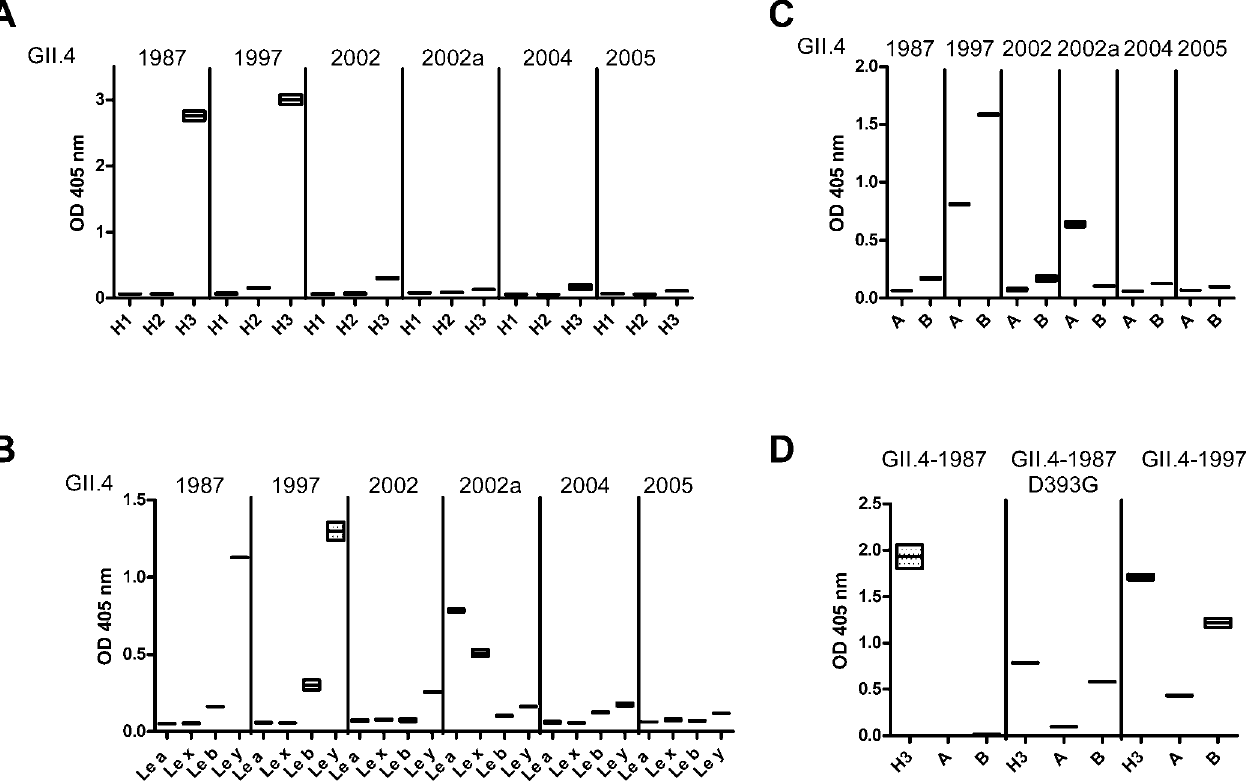
Figure 7. GII.4 VLP–Carbohydrate Binding Patterns at Room Temperature VLPs were assayed for ability to bind to synthetic biotinylated HBGA bound to avidin-coated plates. The mean optical density is indicated by the line in the box. The upper and lower boundaries of the box represent the maximum and minimum values. (A) VLP binding to core chains including an a -1,2-fucose. (B) VLP binding to either core chains or H antigens modified with the Lewis antigen. (C) VLP binding to A or B antigen trimer. (D) Comparison of binding of GII.4–1987, GII.4–1987 D393G, and GII.4–1997 VLPs to select